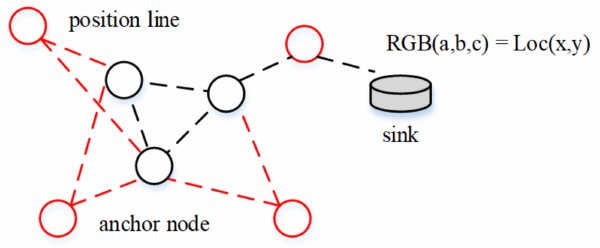
Figure 3. The system model of CEER